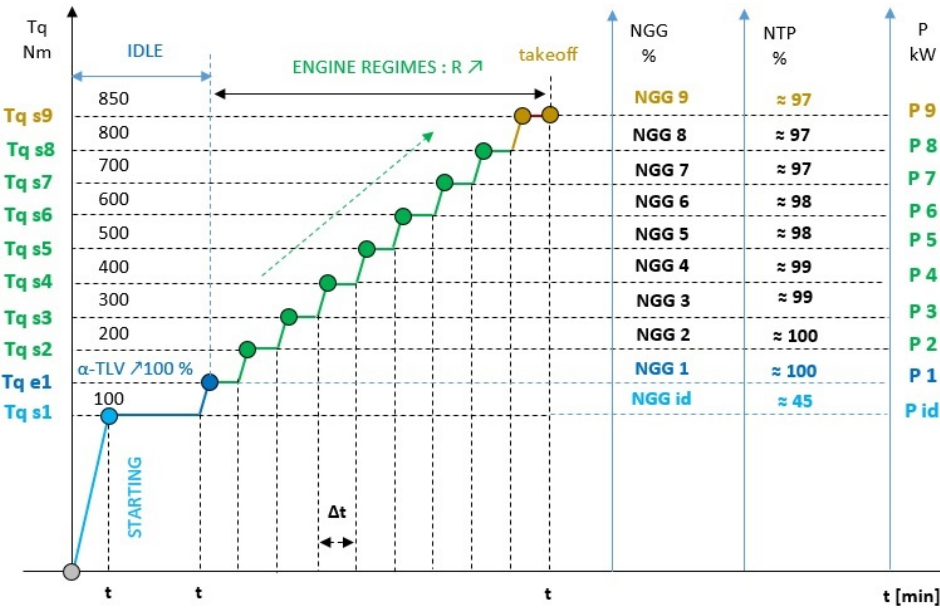
Figure 8. General testing procedure of TV2-117A free turbine turbo-shaft.